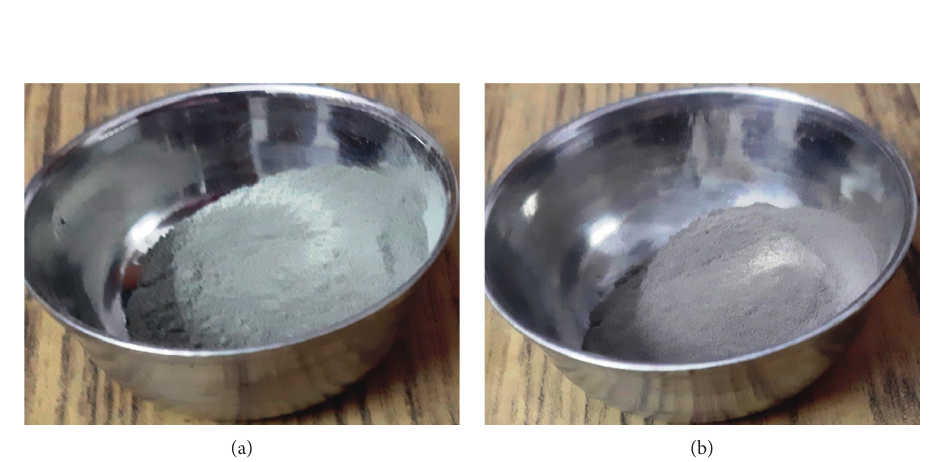
Figure 1: Images of materials used. (a) Ordinary Portland cement. (b) LD slag.